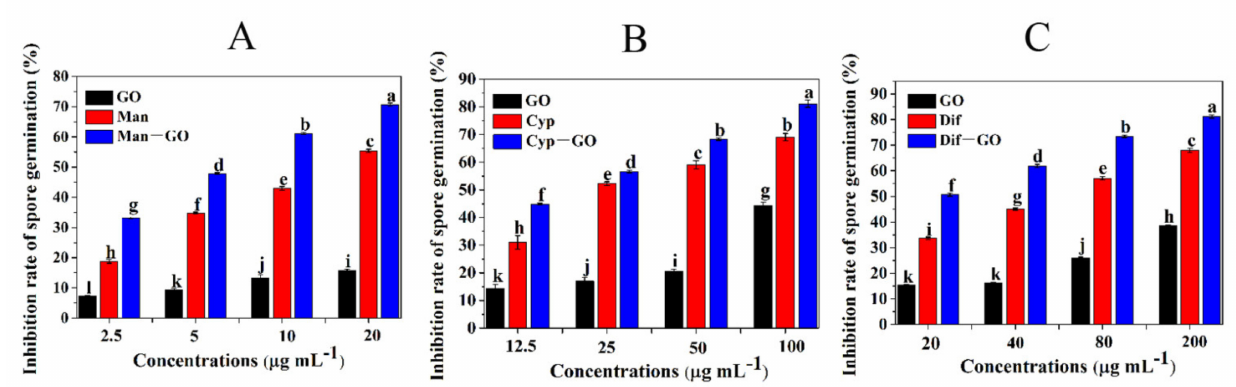
Figure 5. Inhibitory activities of GO and GO–fungicides on the spore germination of F. graminearum . The inhibition rate of spore germination was evaluated at different concentrations of GO and Man–GO ( A ), Cyp–GO ( B ) and Dif–GO ( C ) after 5 h of incubation. Error bars represent the standard error (N = 5). Different lowercase letters indicate significant differences between treatments ( p <